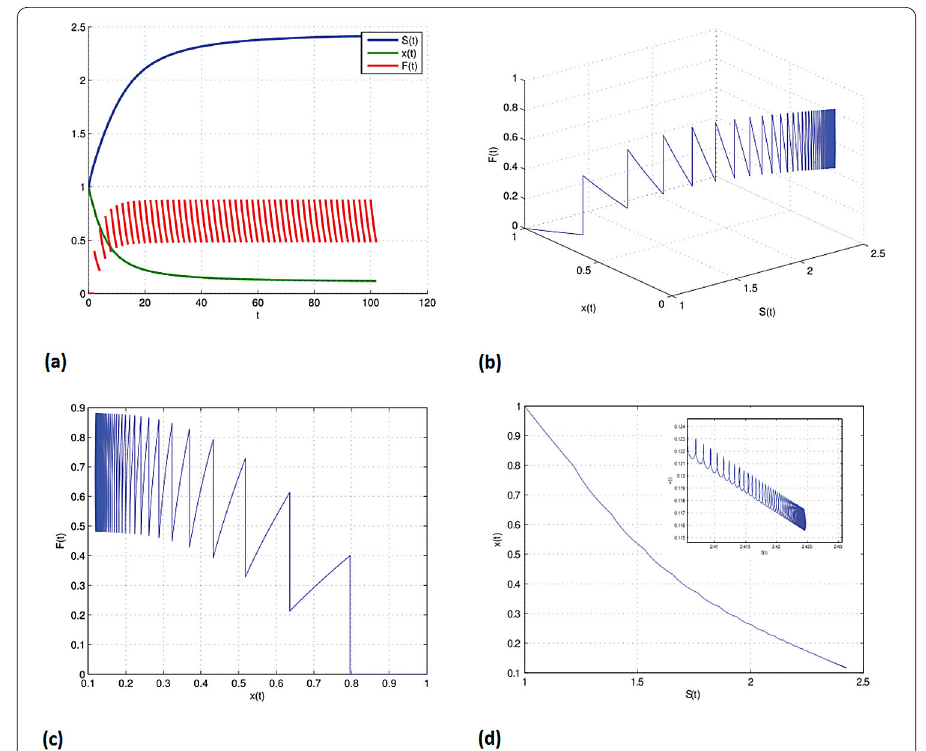
Figure 4 Dynamical behavior of solutions of system (26) with R 2 = 1.0647 > 1. (a) Time series of S ( t ), x ( t ), F ( t ). (b) Three-dimensional phase diagrams of S ( t ), x ( t ), F ( t ). (c) Phase diagrams of x ( t ), F ( t ). (d) Phase diagrams of x ( t ), S ( t